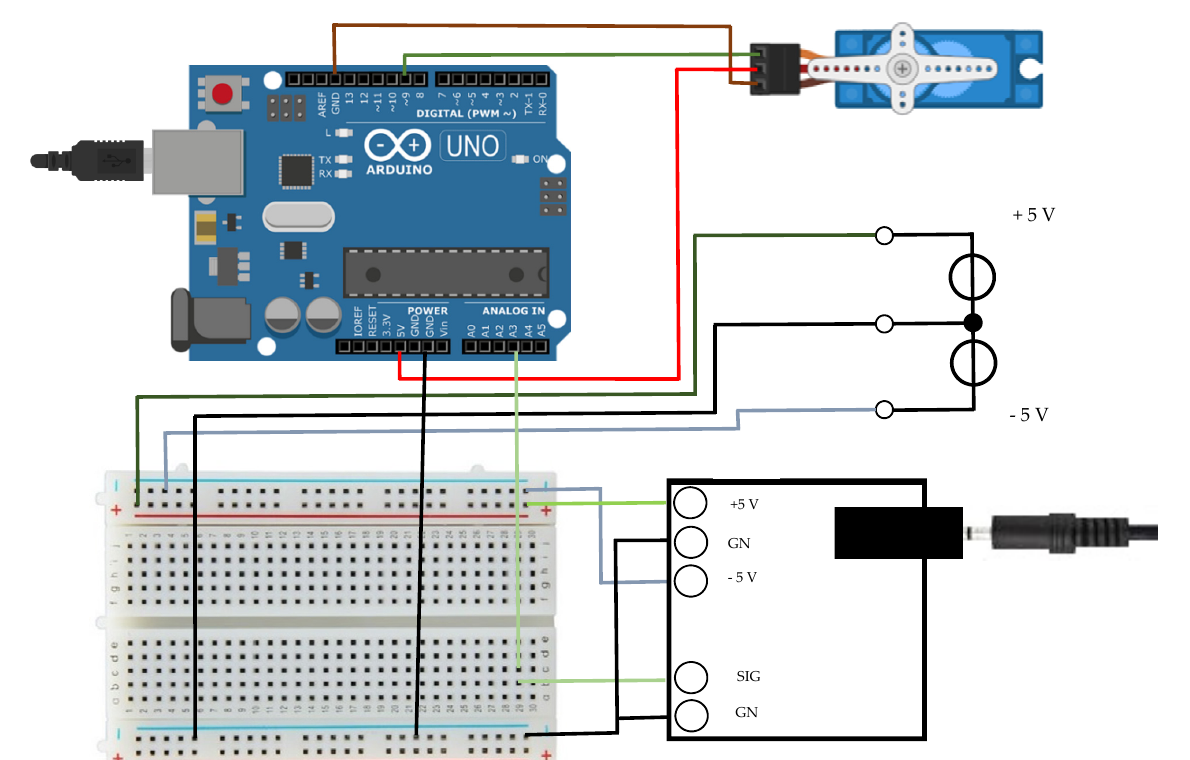
Figure 2. Electronic setup with Arduino Uno (upper left), servomotor (upper right), breadboard connections (lower left) and muscle sensor board (lower right).